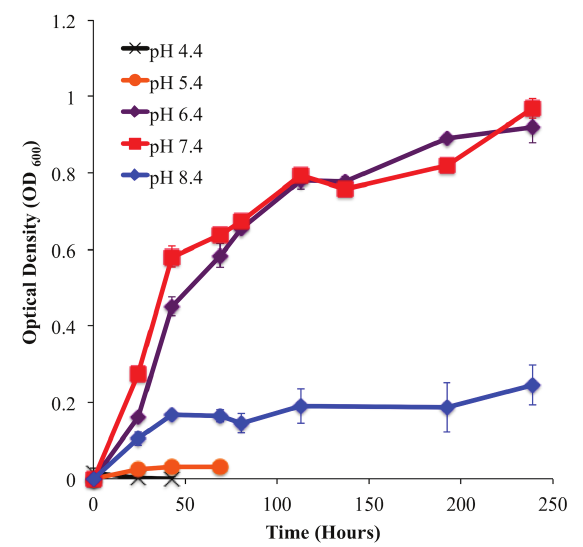
Figure 1. Growth Curve of Hla cultures grown under acidic and alkaline conditions. Growth of Halorubrum lacusprofundi at pH 4.4 (black ×s), pH 5.4 (light green circles), pH 6.4 (light blue diamonds), pH 7.4 (red squares), and pH 8.4 (blue diamonds). Values for the symbols are the average of all replicates and the error bars represent the standard deviation at each time